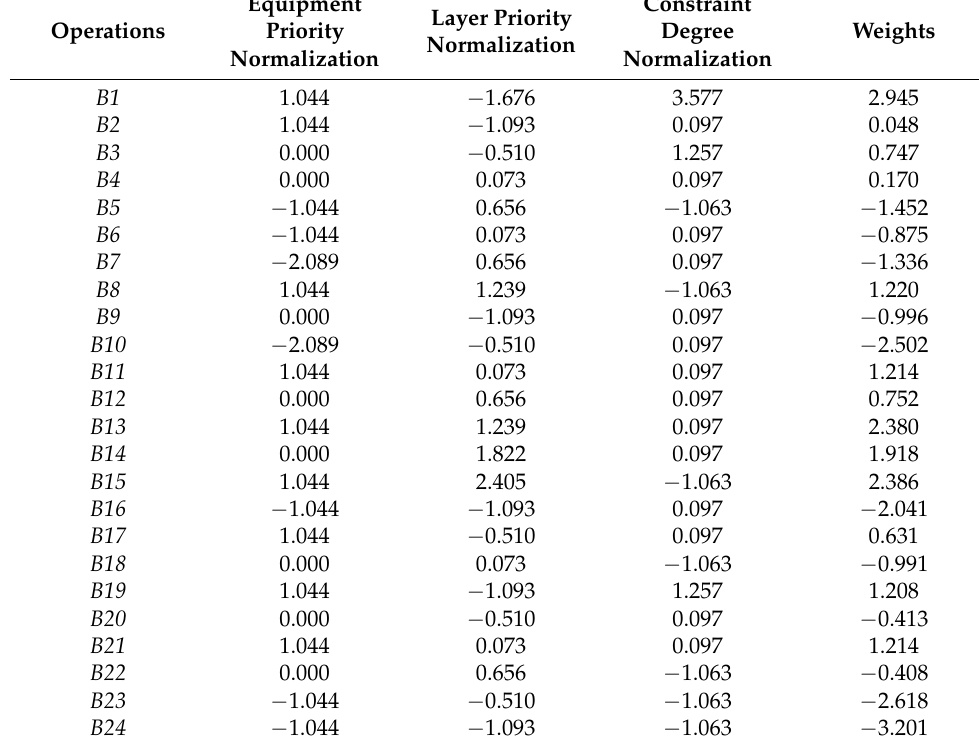
Table 2. Statistical table of the weight of each operation of complex product